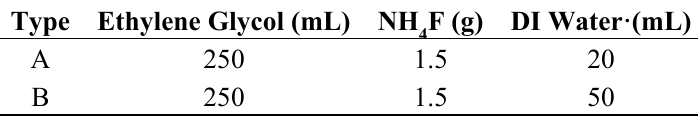
Table 1. The composition of electrolytes.